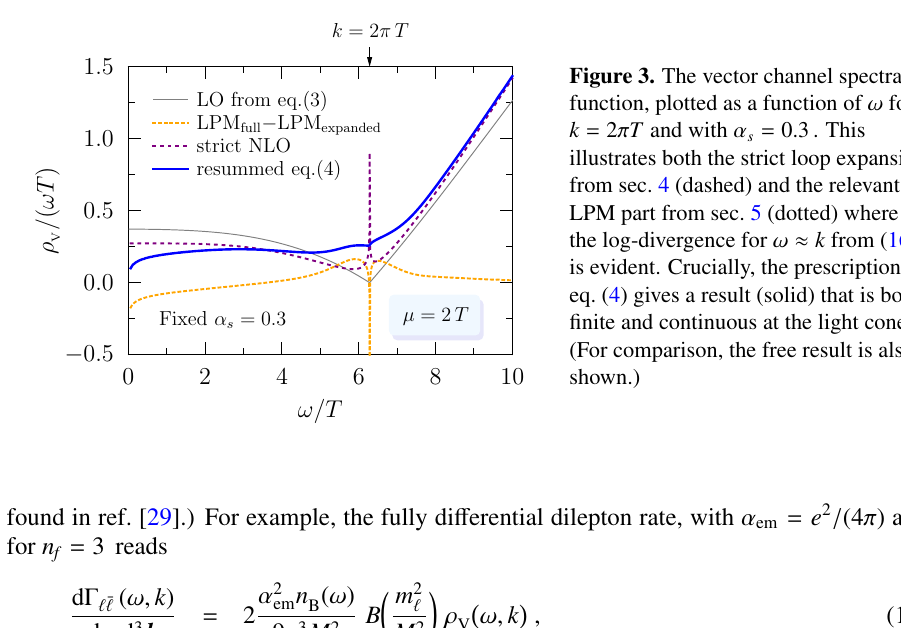
Figure 4. Invariant mass distribution of the di ff erential rate to product an e + e − pair, d Γ ee ≡ d N / d 4 X , computed from eq. (18) after converting to hyperbolic coordinates and integrating over the azimuthal angle and k ⊥ at midrapidity. We show the resummed NLO result from (4) (solid) and the LO result from (3) (dotted), at the temperatures T = { 180 , 300 , 500 } MeV. The running of α s has been implemented as described in ref.